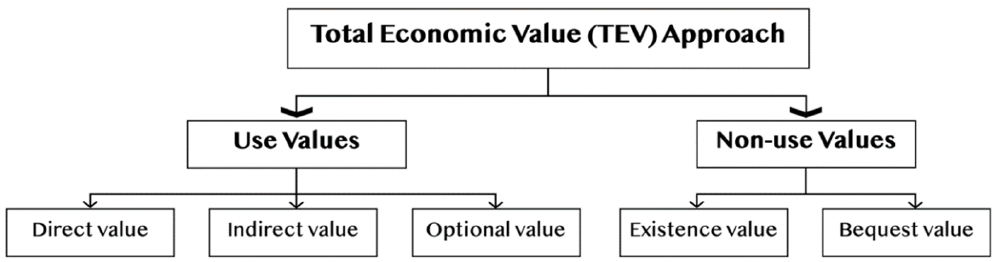
Figure 4. Main components of the Total Economic Value (TEV) Approach. Source: adapted from (Nature Conservancy et al., 2004; Pascual et al., 2015; Tinch et al., 2019; UNEP, 2010).